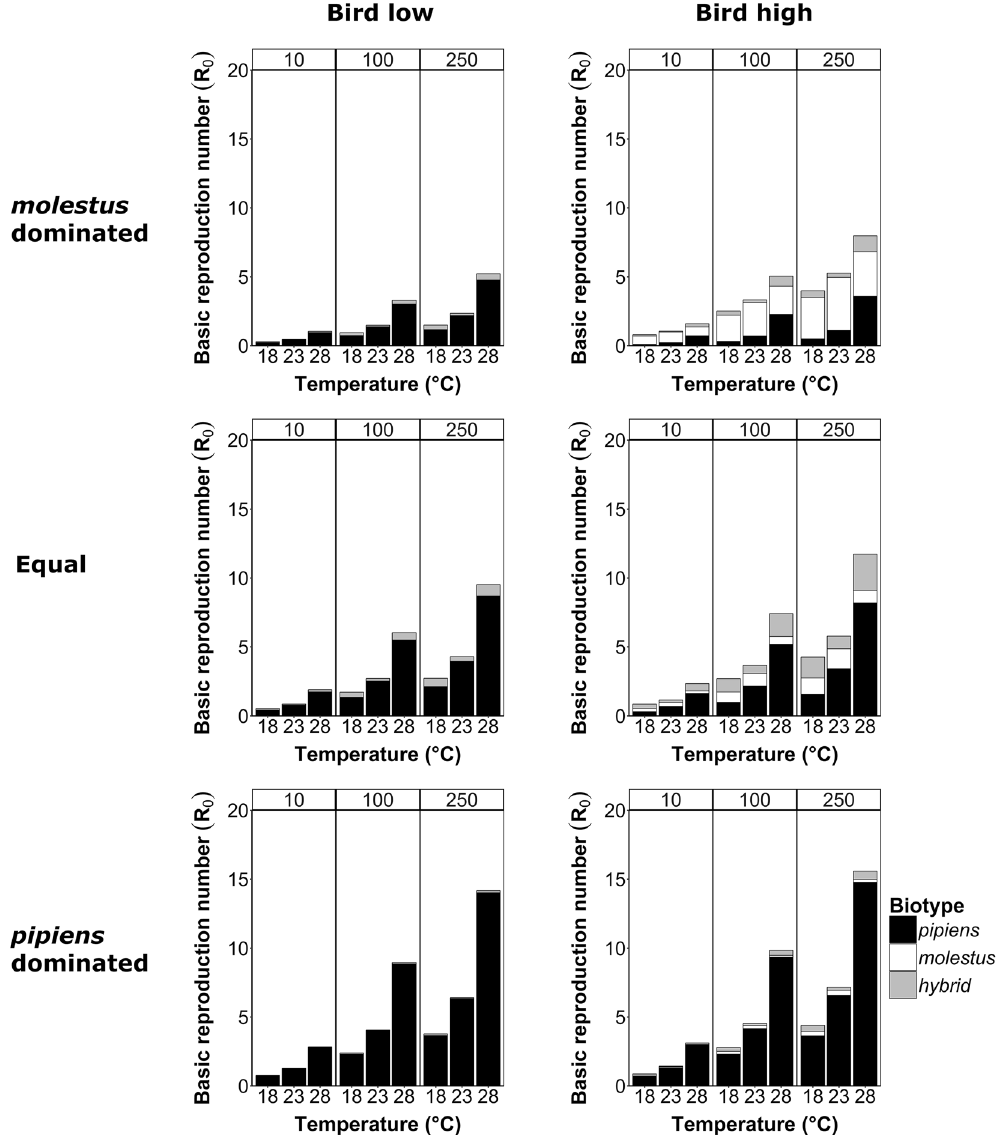
Figure 3. Contribution of each Culex pipiens biotype to scenarios for West Nile virus transmission in Europe. The six plots show the results for low or high fractions of birds in the host population (FB = 0.2 and FB = 0.8, respectively) and one of the three different mosquito population compositions ( molestus dominated, equal fractions, or pipiens dominated). Each plot shows the contribution of biotype pipiens , biotype molestus or hybrids to the R 0 values for three temperature scenarios (T = 18 °C, 23 °C, and 28 °C) and three different mosquito-to-host ratios ( C = 10, 100, or 250). Values of R 0 above one indicate that there is a chance of West Nile virus